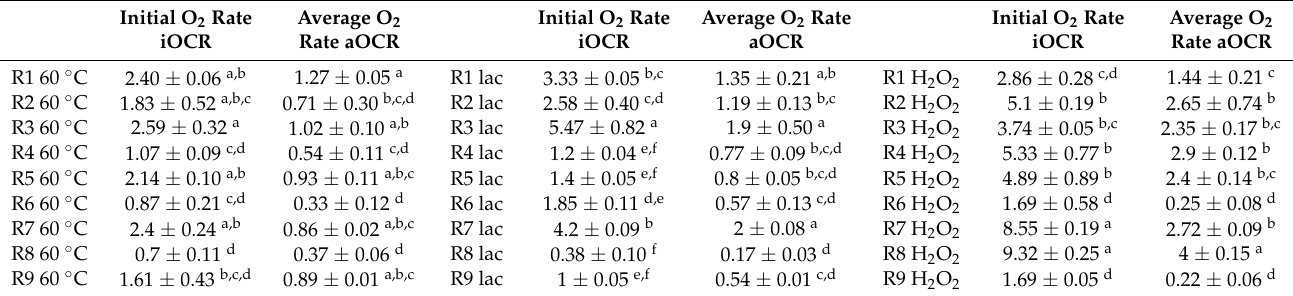
Table 2. Oxygen consumption rates (ppm · h − 1 ) of wines for the accelerated ageing tests. Values represent means of triplicate determination ± SD. Initial O 2 rate (iOCR) is calculated as tangent to the linear regression O 2 = f (time) in the first 30 min. Average O 2 rate (aOCR) is calculated between the first O 2 value before the aging test and the first O 2 value of the final threshold. Different letters indicate the significant differences between samples in one column according to Tukey’s test, p <